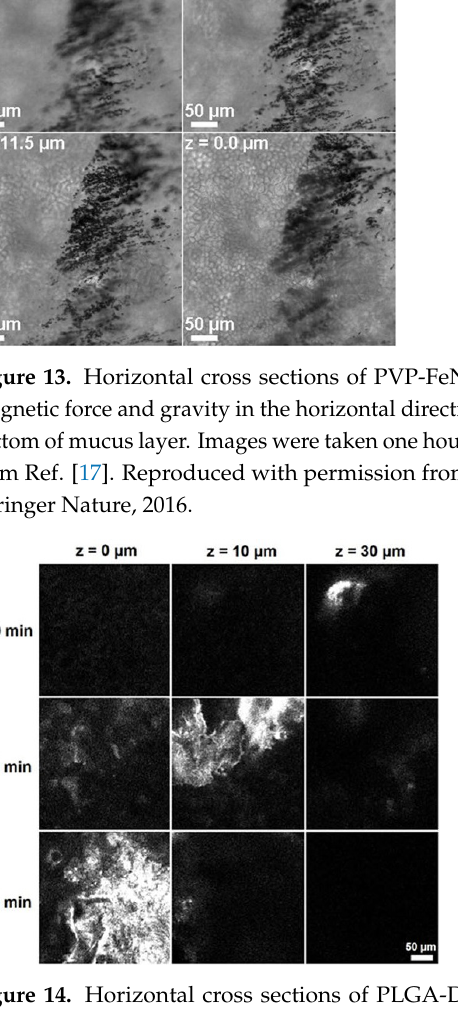
Figure 14. Horizontal cross sections of PLGA-Dex-FITC-BaNp aggregate distribution in mucus. There is no magnetic force and gravity in the horizontal direction, only diffusion effects exist. z = 0 represents the bottom of mucus layer. Images were taken at 10, 20, and 30 min after releasing MNPs. This figure is taken directly from Ref. [17]. Reproduced with permission from Economou,